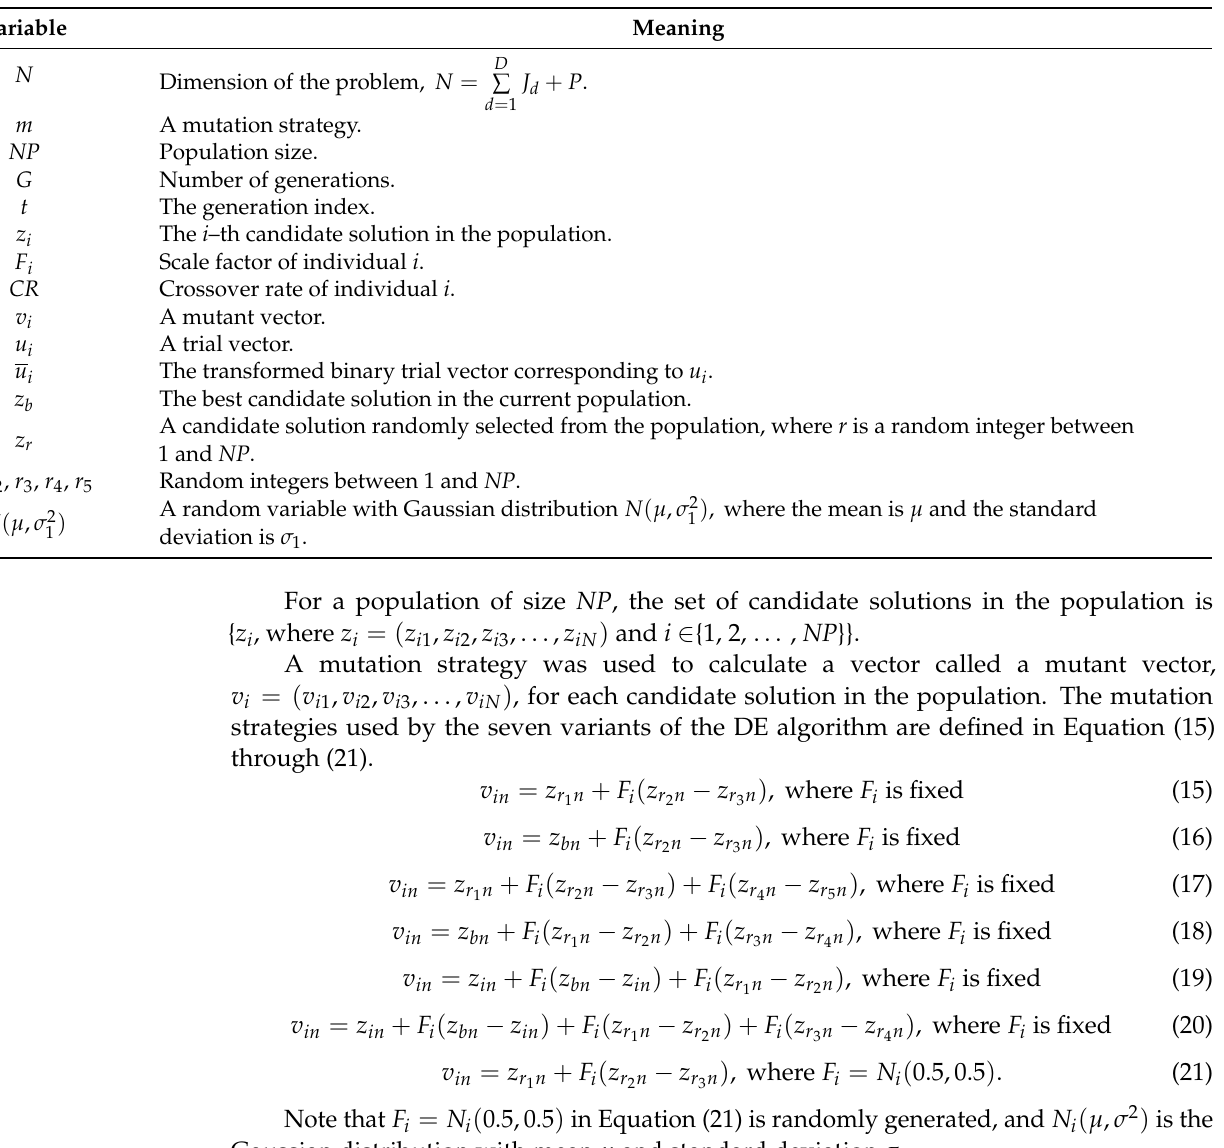
Table 2. Notations of symbols, variables, and parameters used in the seven DE